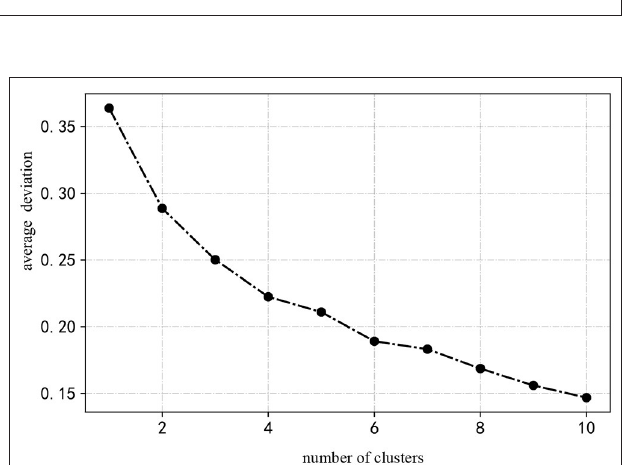
FIGURE 1 | Research framework used in this study.